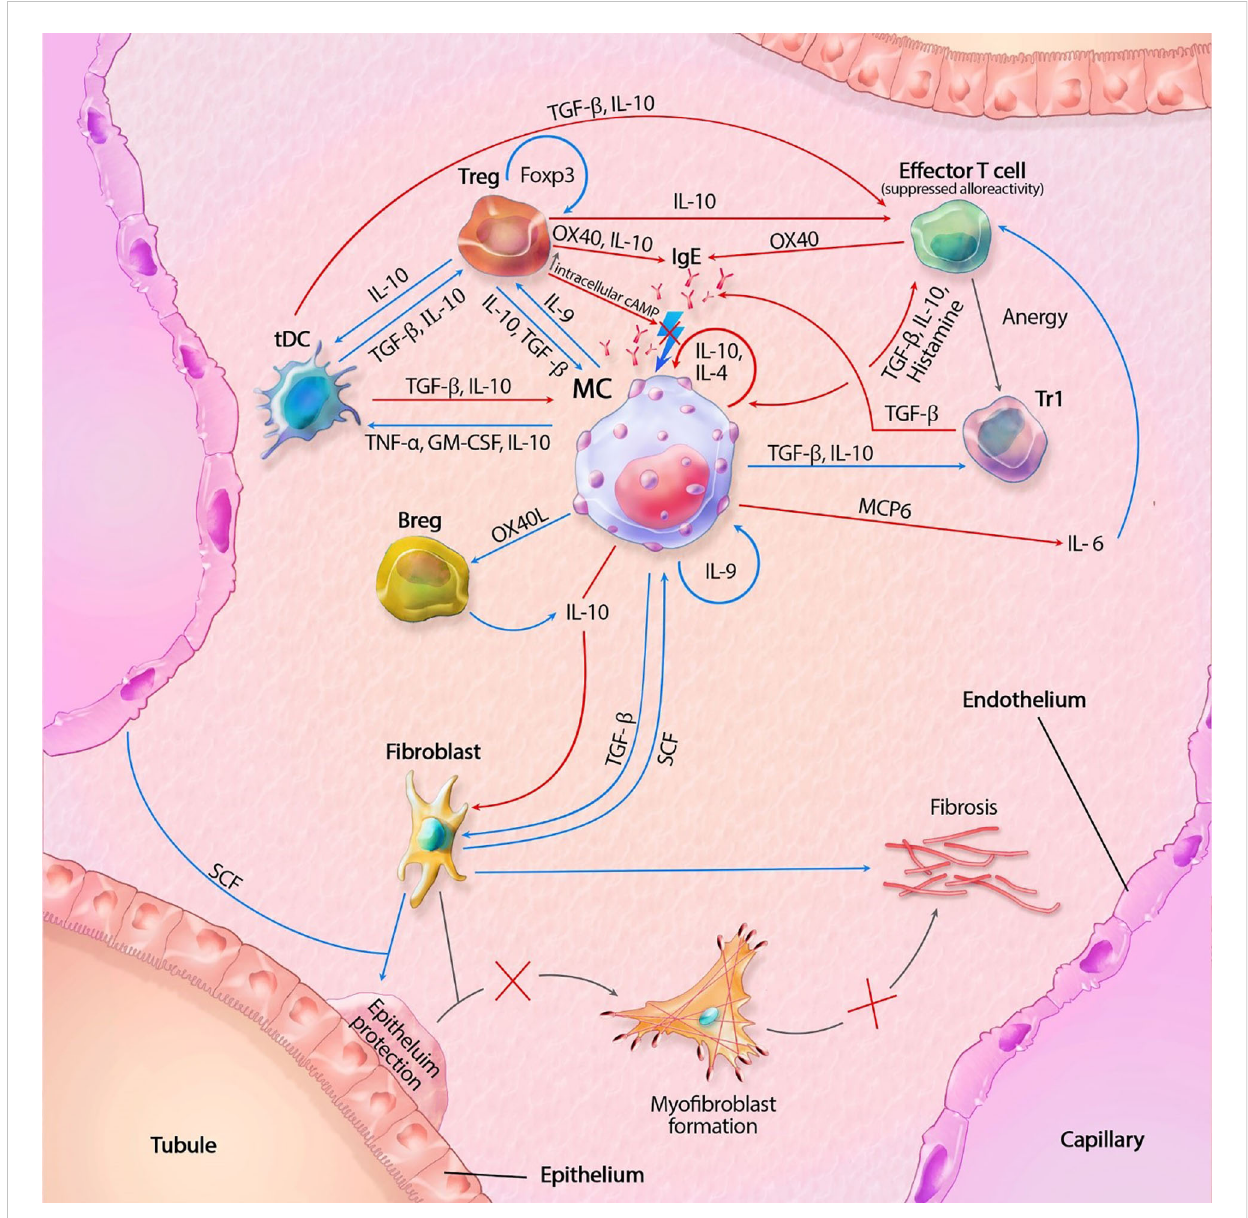
FIGURE 1 Mast cell (MC) interactions within the transplant during tolerance. Fc ϵ RI activity is inhibited by TGF- b , IL-10 and OX40 ligation. Tregs also inhibit degranulation by lowering intracellular Ca 2+ levels through increased cAMP. IL-10 suppresses alloreactivity within CD4+ and CD8+ T cells and promote anergy and regulatory functions of CD4+ T cells. IL-10 mediated inhibition of fi broblasts also inhibit subsequent formation of myo fi broblasts. IL-10 with co-stimulation of IL-4 decrease MC proliferation, while IL-9 increases proliferation. GM-CSF, granulocyte-macrophage colony-stimulating factor; IL, interleukin; MCP6, mat cell protease 6; SCF, stem cell factor; tDC, tolerogenic dendritic cell; TGF- b , tissue growth factor beta; TNF- a , tissue necrotic factor alpha; Tr1, regulatory T cell type 1 (induced); Treg, regulatory T cell (natural); Blue lines symbolize activating pathways, red lines inhibitory pathways, gray lines symbolize subsequent events. Lighting icons are used in the most profound activation patterns, which are inhibited in tolerogenic